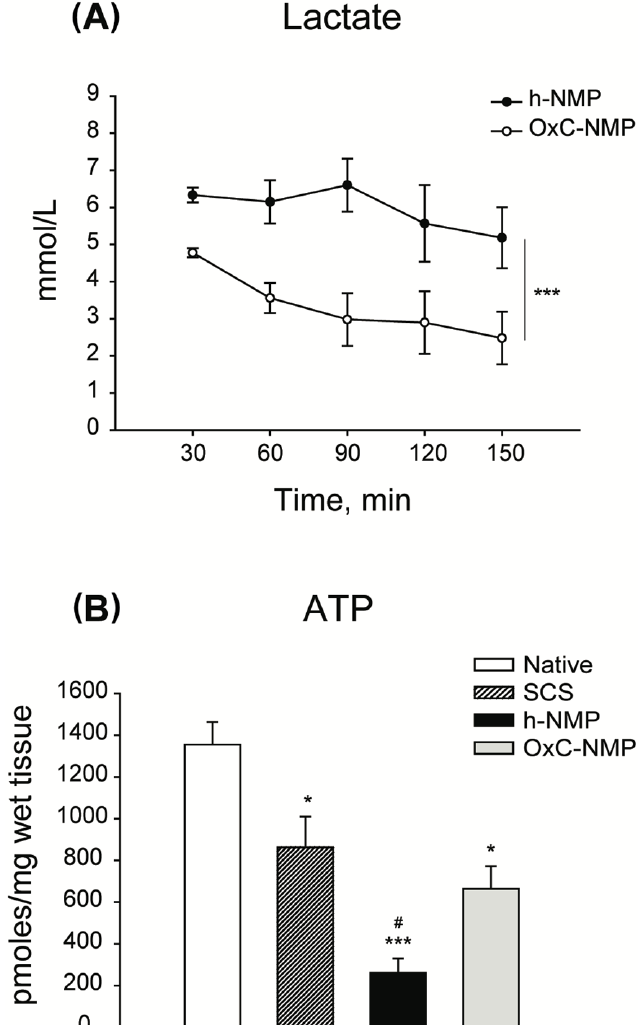
Figure 1. Characterization of viability and function of livers subjected to normothermic machine perfusion (NMP). ( A ) Perfusate lactate concentration throughout NMP. Two-way repeated measures ANOVA, *** p < 0.001. ( B ) Liver ATP content. ATP was measured in liver biopsies by means of bioluminescent assays. One-way ANOVA, Tukey’s post hoc test; p values vs. Native: * p < 0.05, *** p < 0.001; p values vs. SCS: # p <